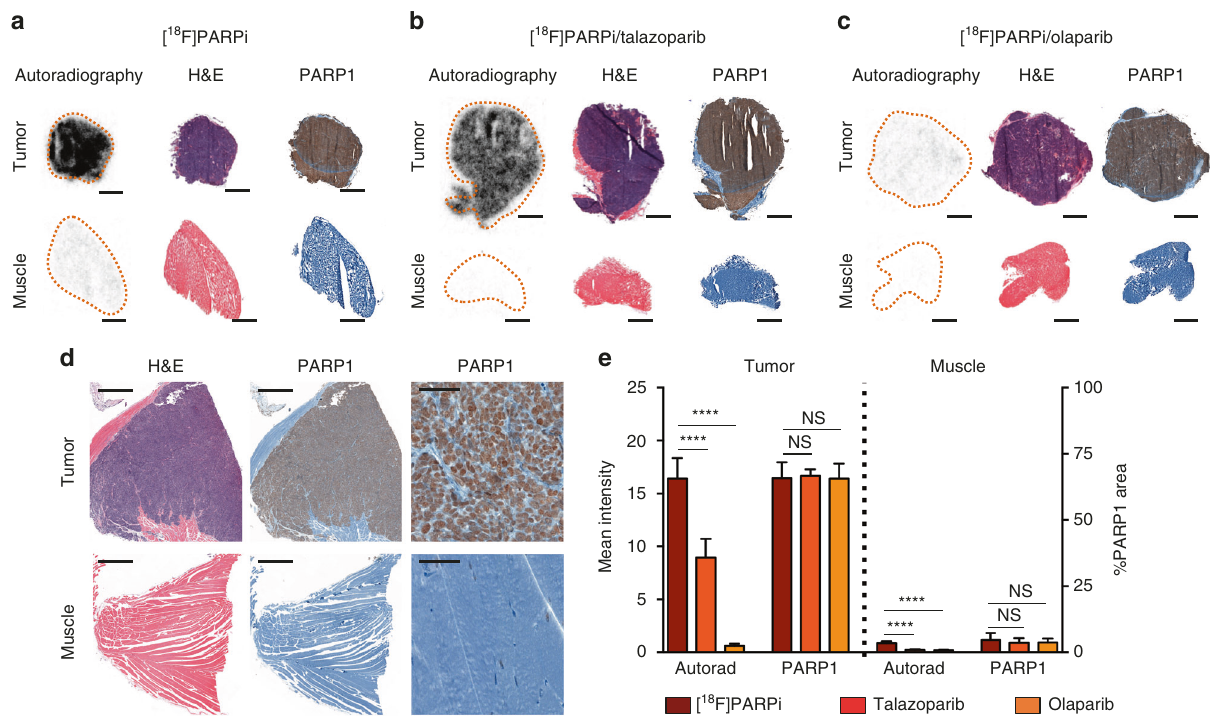
Fig. 6 Autoradiography. JHU-LX48 SCLC PDX bearing mice ( n = 3/group, 3 groups, 9 mice total) were injected either with 200 – 300 μ Ci of [ 18 F]PARPi (i.v.) alone, or with a previous injection of talazoparib (0.3 mg/kg) or olaparib (50 mg/kg) 30 min prior to [ 18 F]PARPi. Tumor (top) and muscle (bottom) were collected 2 h post [ 18 F]PARPi injection, sectioned and either exposed overnight (autoradiography), stained with H&E or stained for PARP1. Example images are shown for a [ 18 F]PARPi alone, b [ 18 F]PARPi with a prior injection of talazoparib and c [ 18 F]PARPi with a prior injection of olaparib. d Higher magni fi cation of PARP1 IHC of a tumor and muscle sample. e Quanti fi cation of autoradiography signal and PARP1 expression. Non-parametric Student ’ s t - test was used to calculate the statistics. **** P < 0.0001. Displayed data represent means with SD from three sections of three